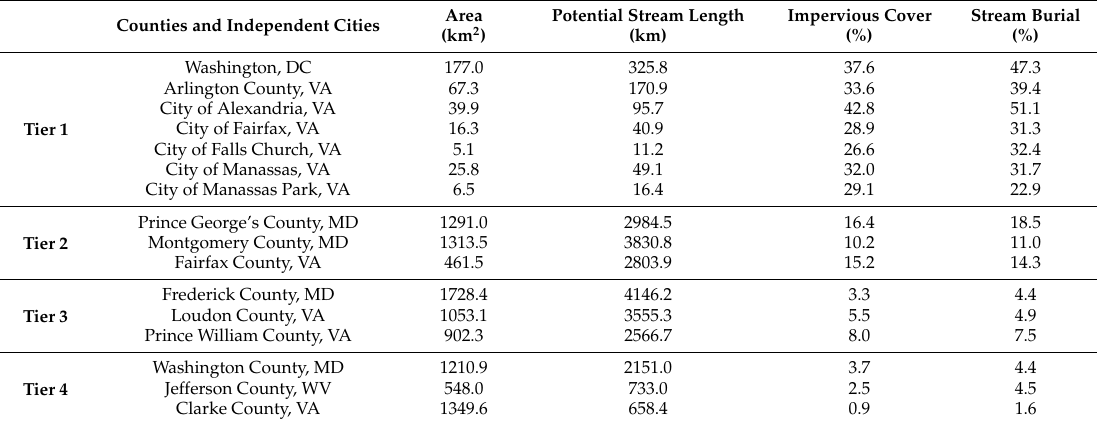
Table 1. Area, stream length, impervious cover and stream burial statistics for the 16 study units. Development ‘tier’ designations correspond with those shown in Figure 2, above.